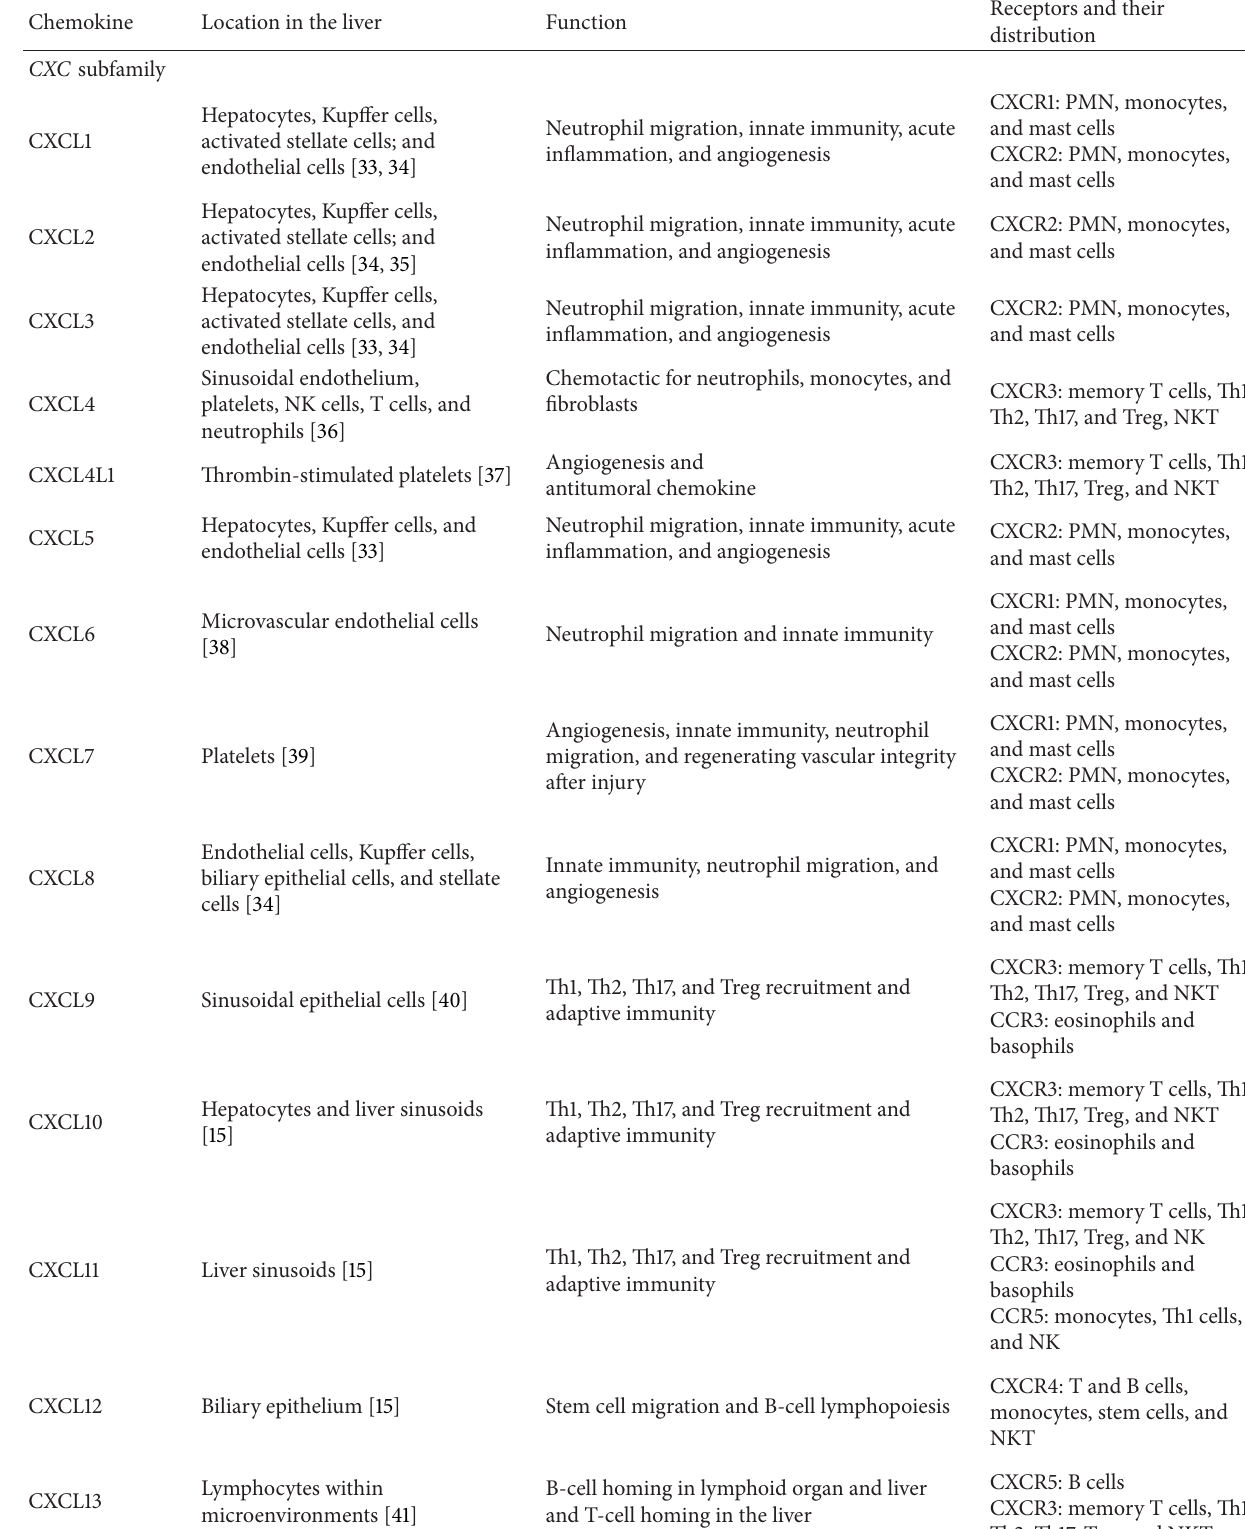
Table 2: Chemokines involved in the pathogenesis of liver